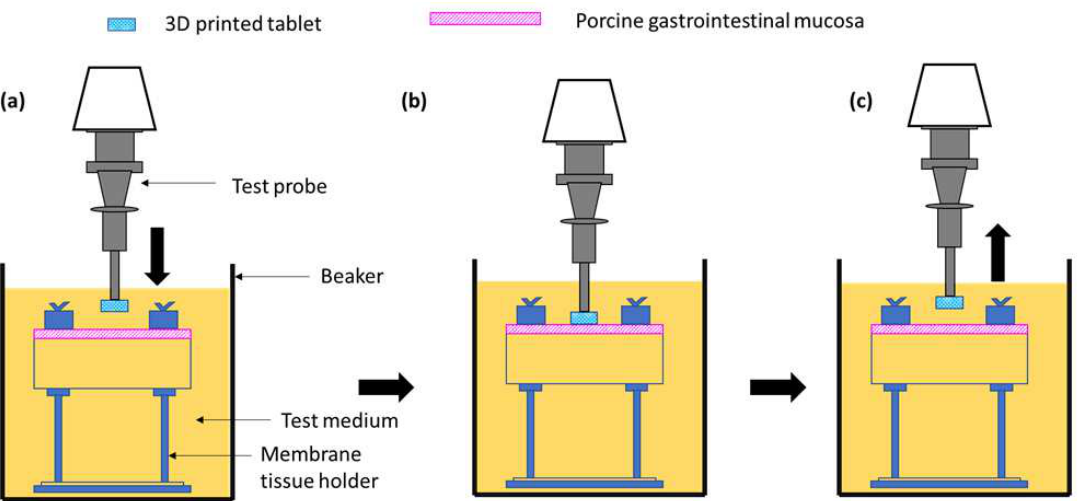
Figure 16. Schematic illustration of the mucoadhesive testing of 3D-printed tablets using the texture analyser with a specialised mucoadhesive holder: ( a ) probe attached with 3D-printed tablet was moved downward; ( b ) 3D-printed tablet was attached with gastrointestinal mucosa with specified force and time; and ( c ) probe was moved upward at a specified rate.